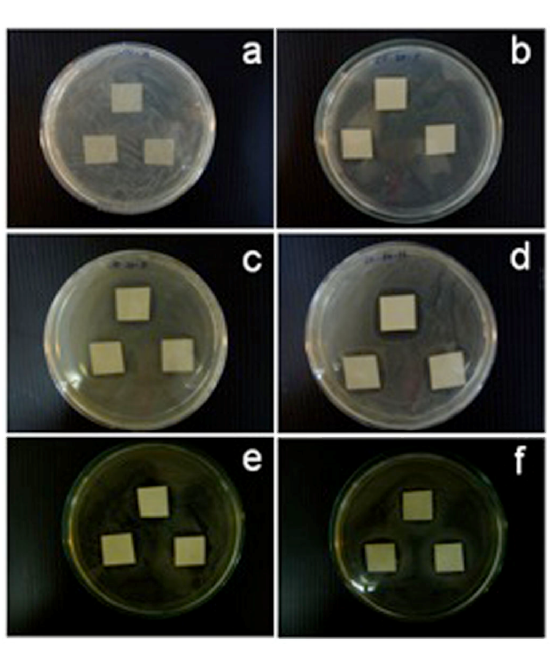
Figure 2: Zone of inhibition observed for different samples of antimi- crobial paper under various conditions: (a) control with no ZnO after 72 h incubation of E. coli under halogen light; (b) 20 mM / 20 h sample after 72 h incubation of E. coli under fluorescent light; (c) 10 mM / 20 h sample after 72 h incubation of E. coli under halogen light; (d) 20 mM / 20 h sample after 72 h incubation of E. coli under halogen light; (e) 10 mM / 20 h sample after 72 h incubation of S. aureus under halogen light; (f) 20 mM / 20 h sample after 72 h incubation of S. aureus under halogen light.